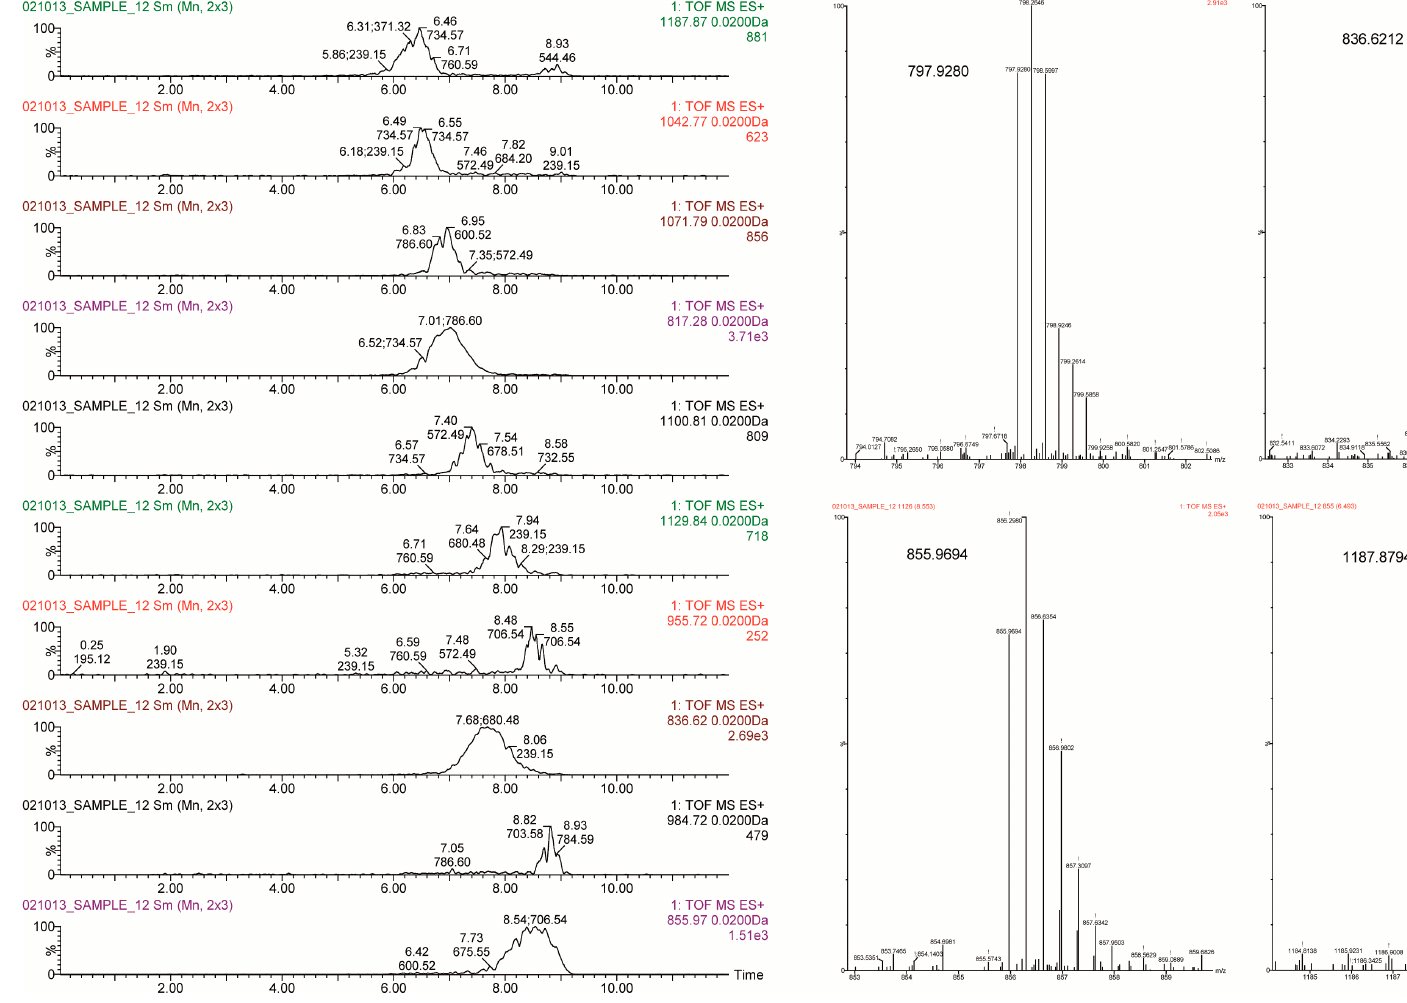
Figure 4. Extracted ion chromatograms (EICs) of some m / z values tentatively ascribed to gangliosides ( left panels). Mass spectra of major m/z values with double or triple charged ions that have been ascribed to gangliosides ( right ).